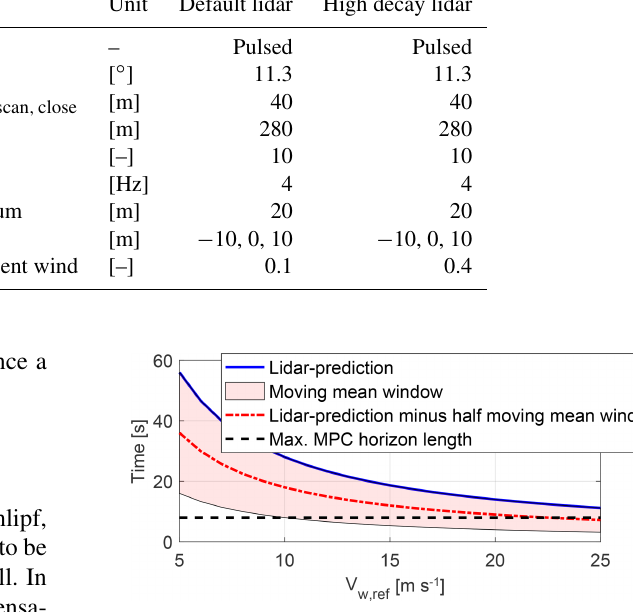
Table 1. Parameters of lidar simulator for the “default lidar” and “high decay lidar” scenarios. Parameter Unit